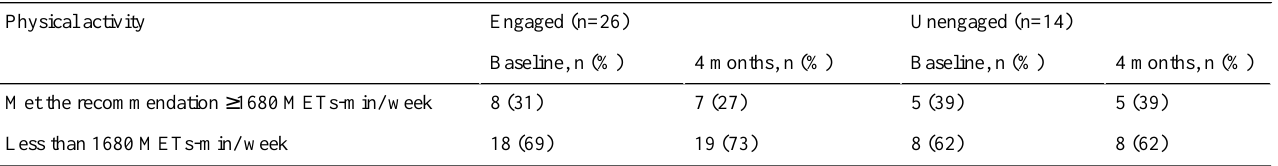
Table 4. Success rate of adherence to recommended daily physical